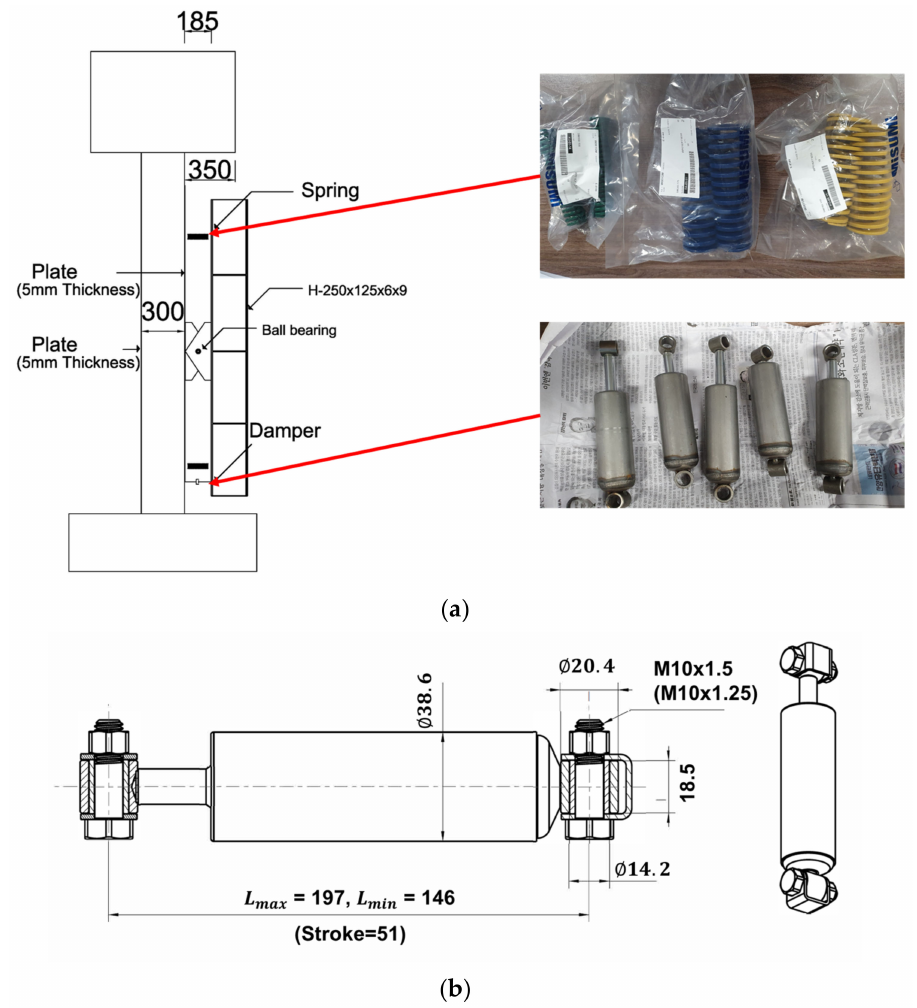
Figure 8. The LTMD system: ( a ) details, ( b ) hydraulic damper (unit: mm).